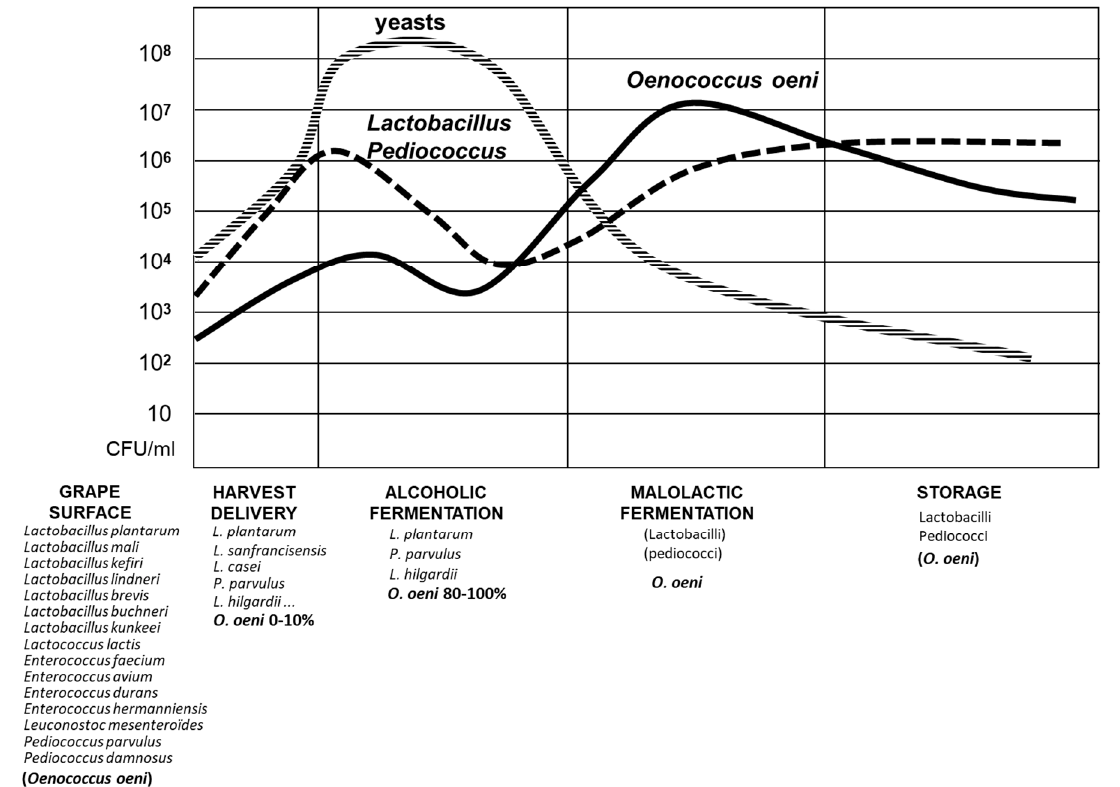
Figure 1. Population kinetics of wine lactic acid bacteria from the vineyard to the wine (Modified from Patrick Lucas, 2016, International ML School Lallemand Toulouse).